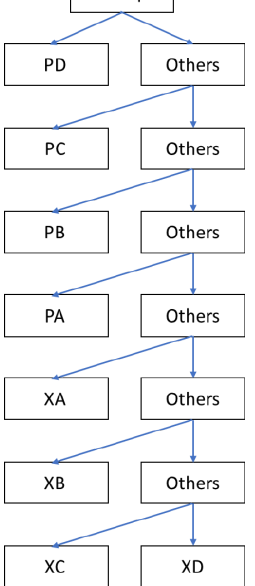
Figure 5. PLS-DA results for the multi-class classification of fermented products according to both quality and variety. Class assignation: A-type pinot noir (PA), A-type xarel·lo (XA), B-type pinot noir (PB), B-type xarel·lo (XB), C-type pinot noir (PC), C-type xarel·lo (XC), D-type pinot noir (PD), and D-type xarel·lo (XD).